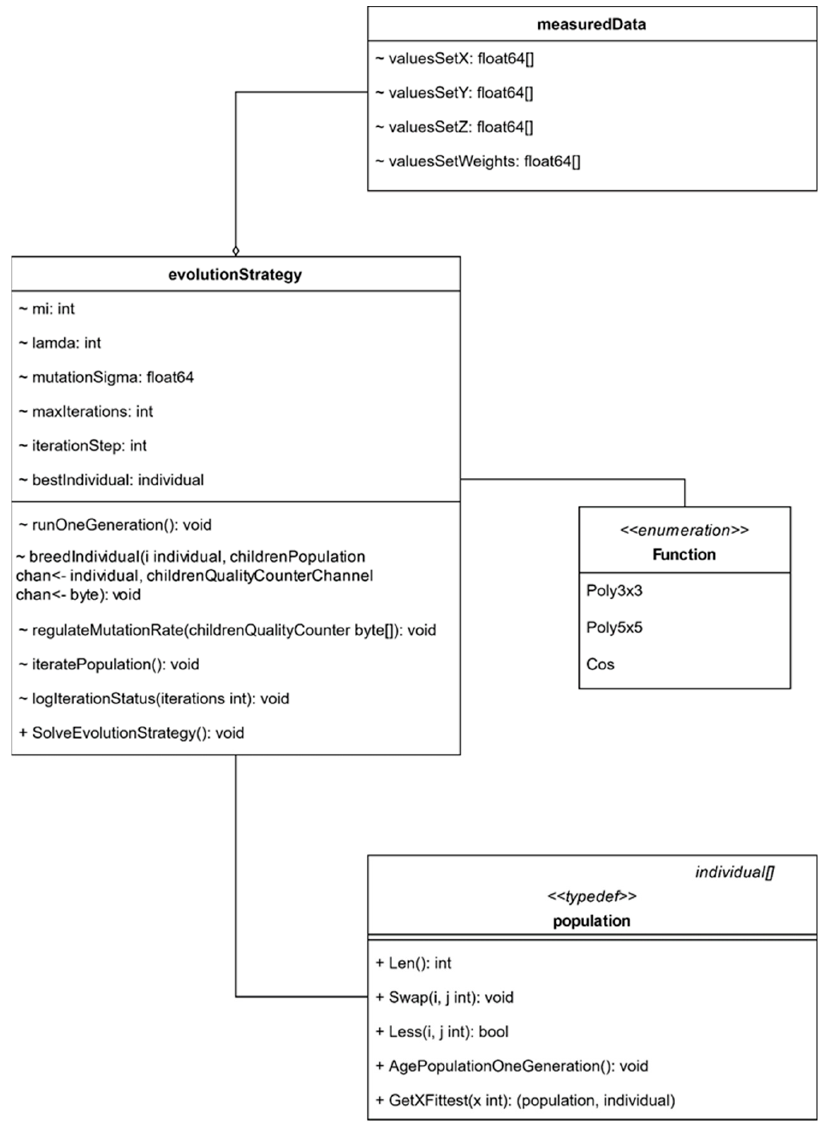
Figure 9. Diagram of implemented classes